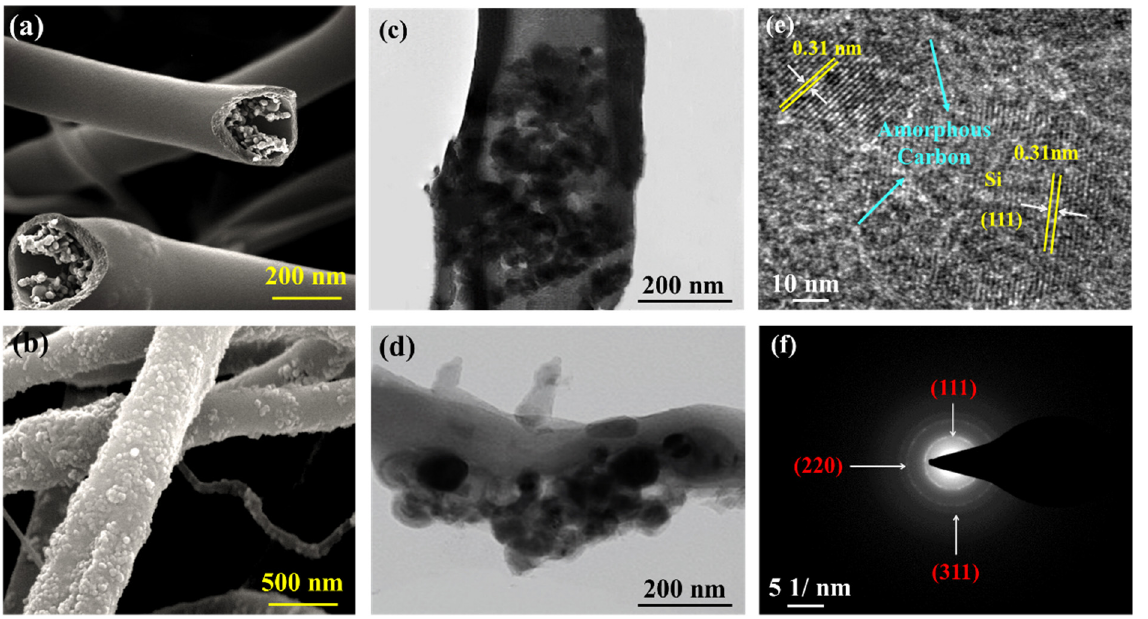
Figure 3. The SEM images of ( a ) Si@C NFs and ( b ) Si/C NFs; TEM images of ( c ) Si@C NFs and ( d ) Si/C NFs at low magnification; HMTEM image ( e ) and corresponding SAED ( f ) of Si@C NFs. The electrochemical performances of Si@C NF and Si/C NF electrodes are shown in Figure 4. The CV curves of Si@C NF and Si/C NF electrodes were tested at a scan rate of 0.1 mV s − 1 with a potential range of 0.01–1.5 V (Figure 4a,c). As shown, during the cathodic